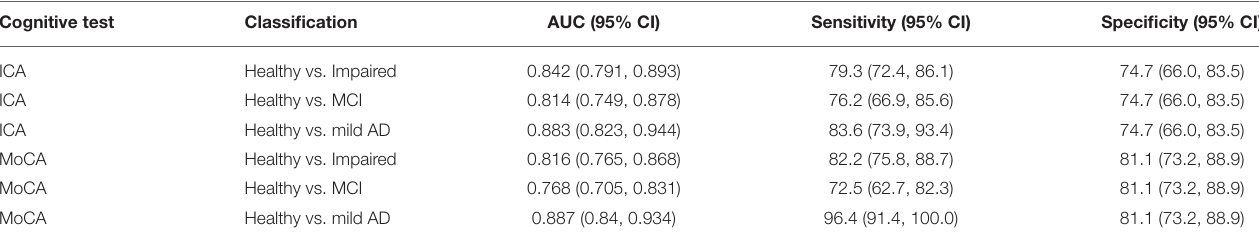
TABLE 5 | Classification performance metrics for ICA and MoCA, with 95% confidence intervals (CI). The AUC for ICA is calculated based on the continuous probability output score. Cognitive test